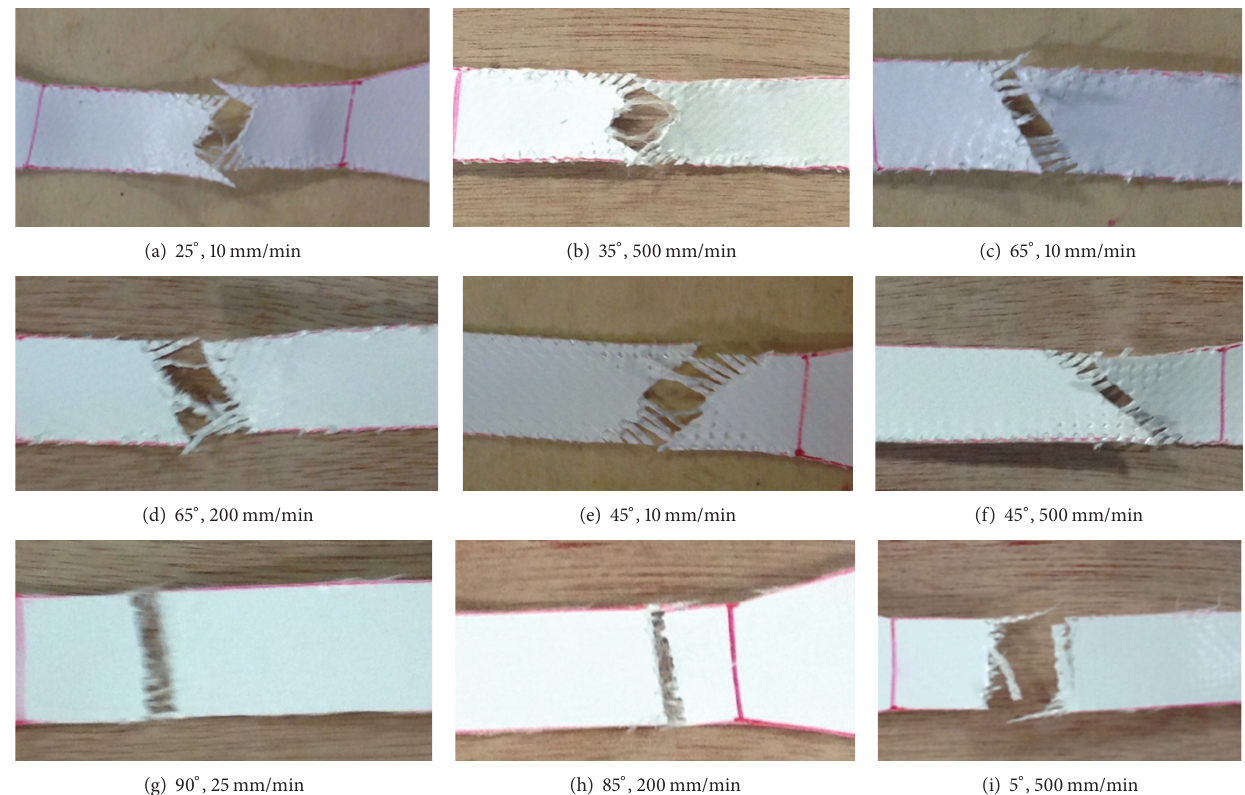
Figure 9: Failure modes of PVDF coated woven fabrics under different tensile